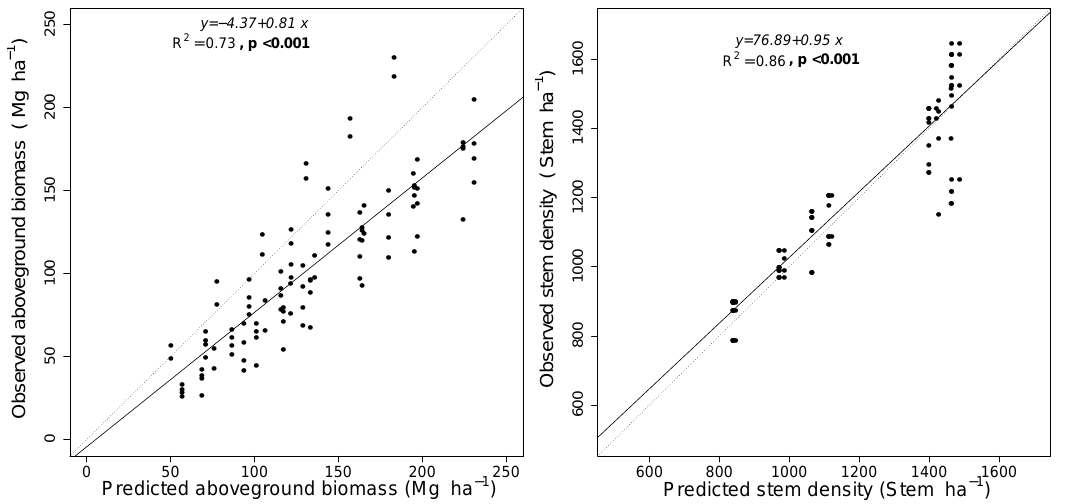
Figure 6. Relationship between observed aboveground biomass (Mg ha − 1 ) and modeled aboveground biomass (left) and measured stem density (stem ha − 1 ) and modeled stem density in the control plots of mid-rotation sites which are independent from the study sites listed in Table 1. Solid lines represent linear fit between observed and predicted values and dotted lines represent the 1:1 line between observed and predicted values.